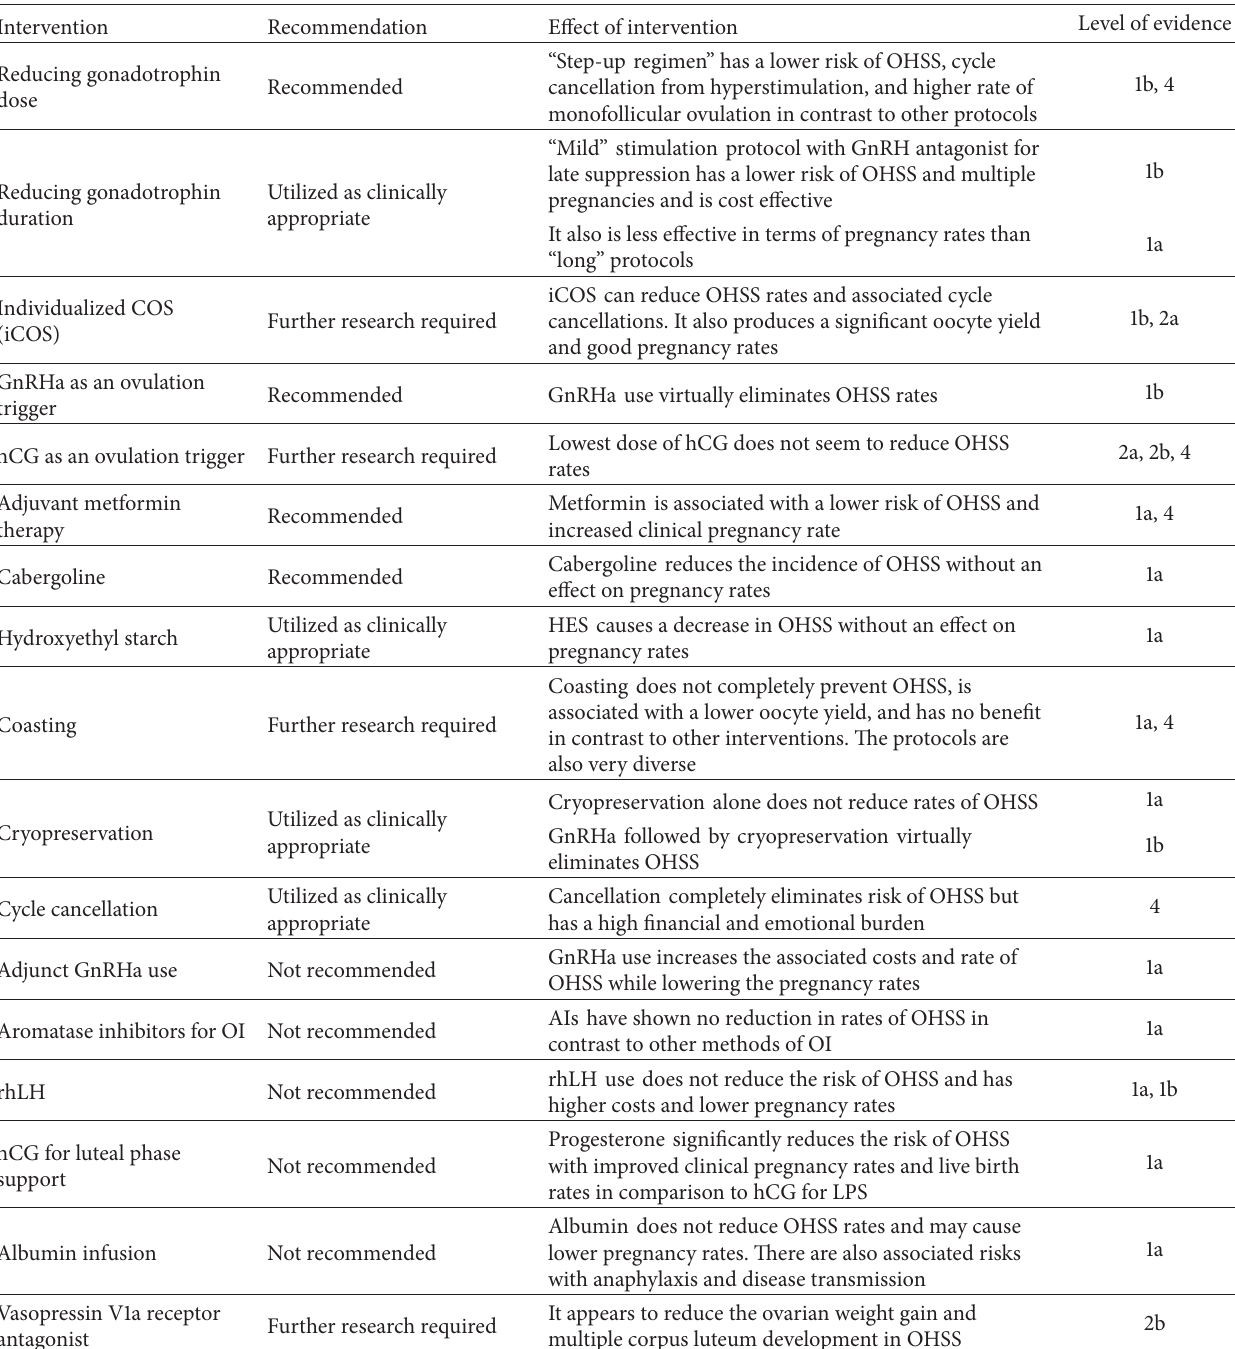
Table 1: Summary of recommendations for strategies to prevent